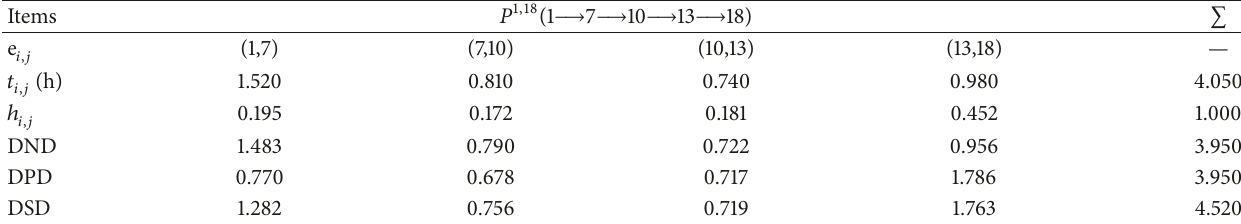
Table 4: The time delay of P 1,18 with the better robustness and the poorer timeliness.